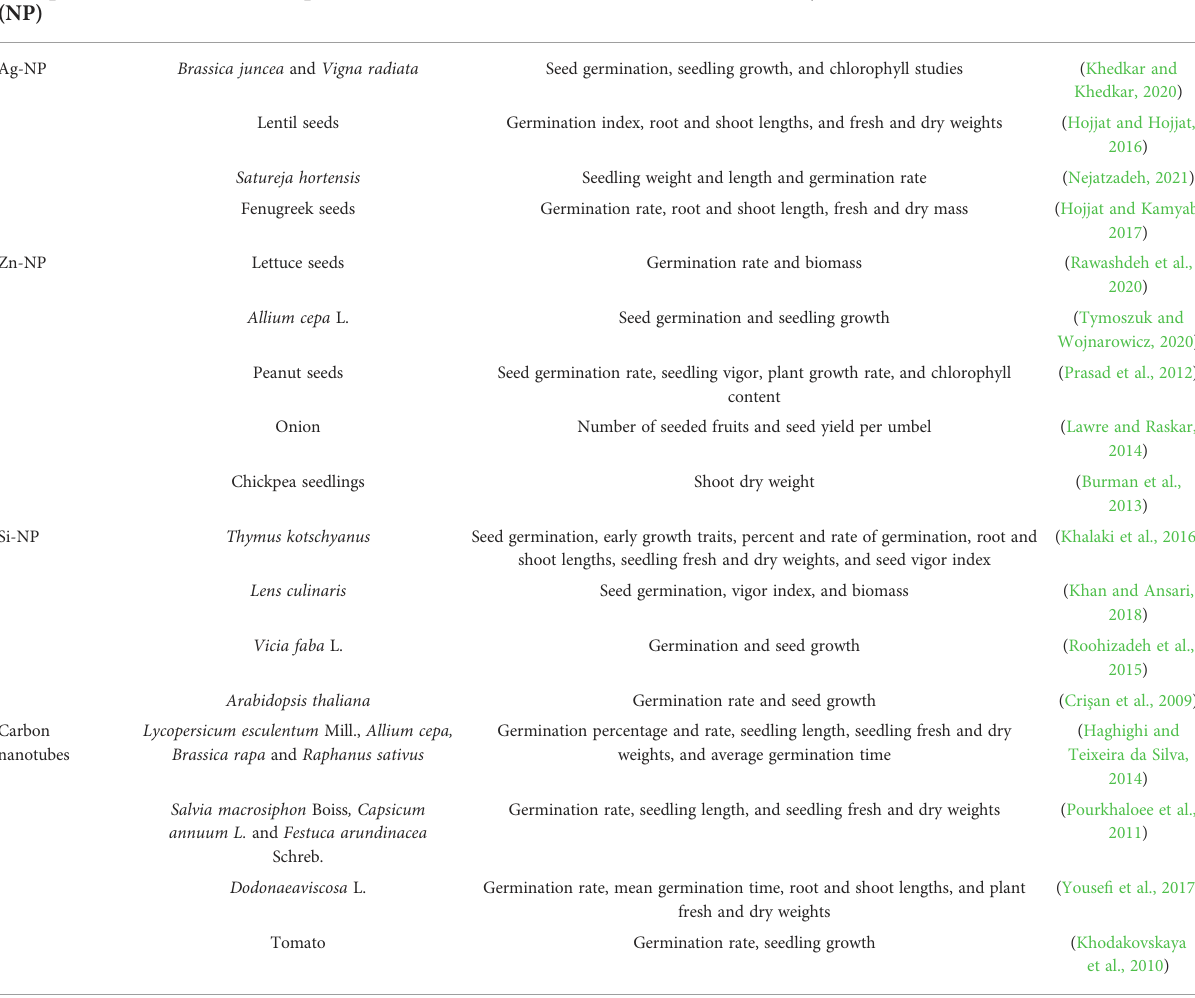
TABLE 3 Applications of Engineered Nano materials in seed germination. Nanoparticle